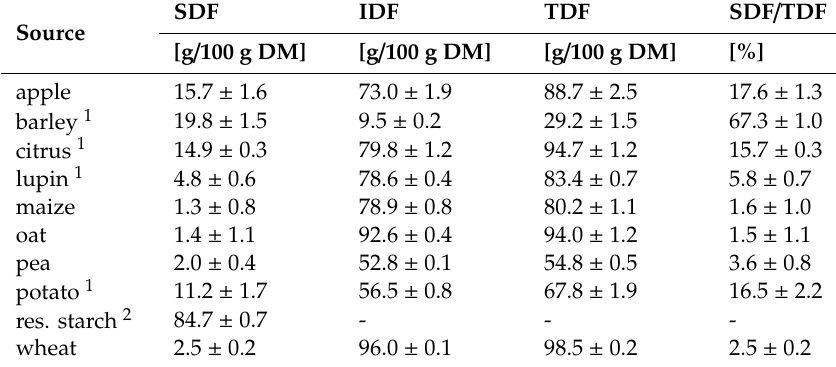
Table 1. Dietary fibre composition (soluble dietary fibre (SDF), insoluble fibre (IDF), and total